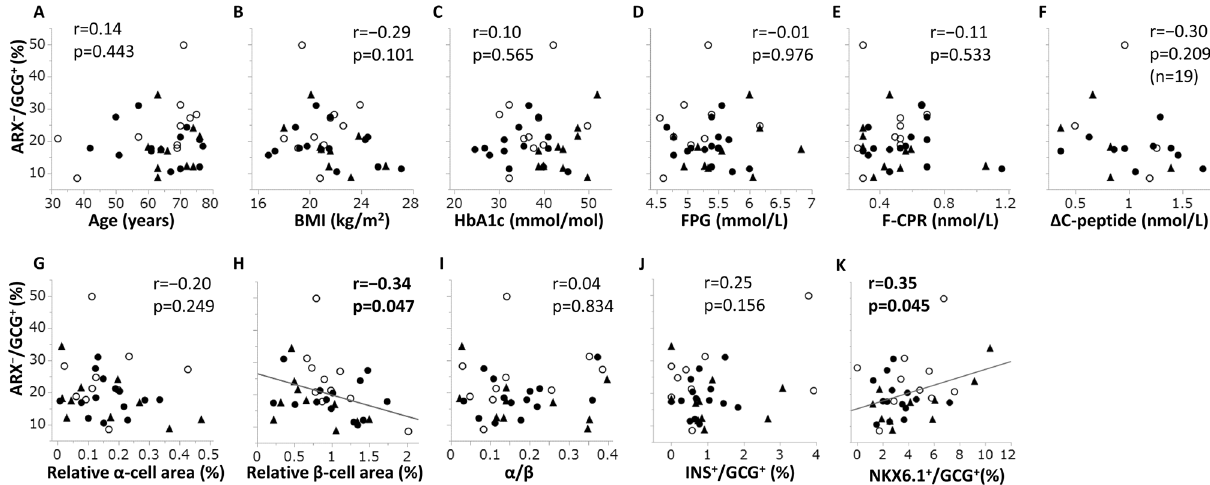
Figure 2. Correlation coefficients between the ARX-negative ratio of glucagon-positive cells and various parameters. ARX-negative ratio of glucagon-positive cells (ARX − /GCG + ratio) and age ( A ), BMI ( B ), HbA1c ( C ), FPG ( D ), F-CPR ( E ), ΔC-peptide ( F ), relative alpha-cell area ( G ), relative beta-cell area ( H ), α/β ( I ), INS + / GCG + ratio ( J ), and NKX6.1 + /GCG + ratio ( K ). Closed circles ( ), normal glucose tolerance; open circles ( ○ ), impaired glucose tolerance; closed triangles ( ▲ ), diabetes; ARX aristaless-related homeobox, FPG fasting ● plasma glucose, F-CPR fasting C-peptide immunoreactivity, ΔC-peptide increment of C-peptide by glucagon test, α/β alpha- to beta-cell area ratio, NKX6.1 NK homeobox 6.1. Pearson’s correlation coefficient was used. r, correlation coefficient; p, p